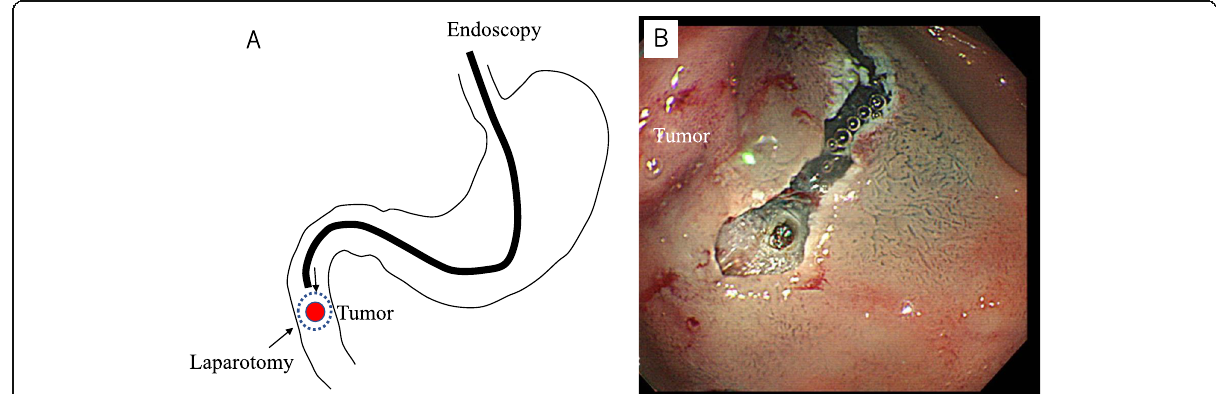
Fig. 3 a Schema of the surgery. Partial duodenectomy was performed using both endoscopy and laparotomy. b A circumferential